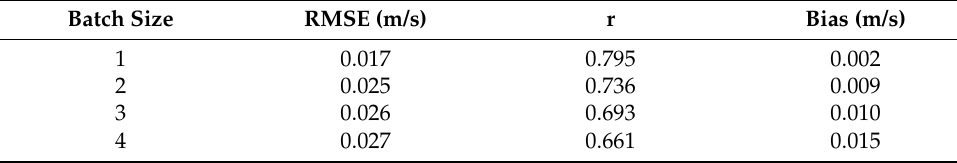
Table 5. Statistics of the estimation results under different batch